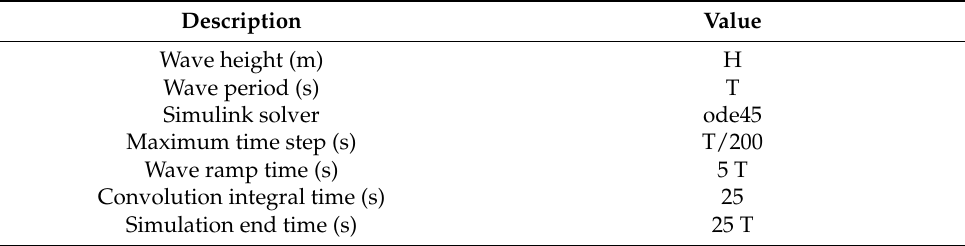
Figure 4. Single WEC model. Table 2. WEC-Sim simulation parameters.